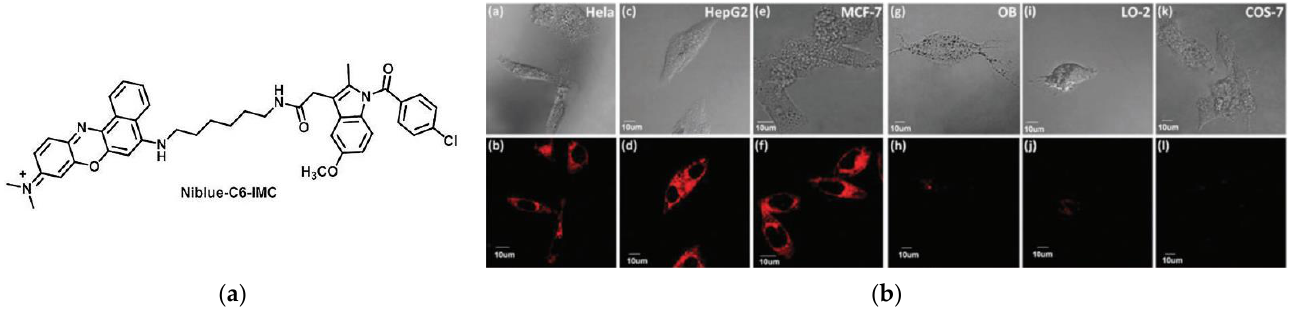
Figure 2. ( a ) Structure of probe Niblue-C6-IMC; ( b ) Confocal imaging of cancer cell lines (MCF-7 cells; HepG2 cells; HeLa cells) and normal cell lines (COS-7 cells; LO-2 cells; OB cells) staining with Niblue-C6-IMC. Reproduced with permission from [39]. Copyright 2015 The Royal Society of Chemistry.